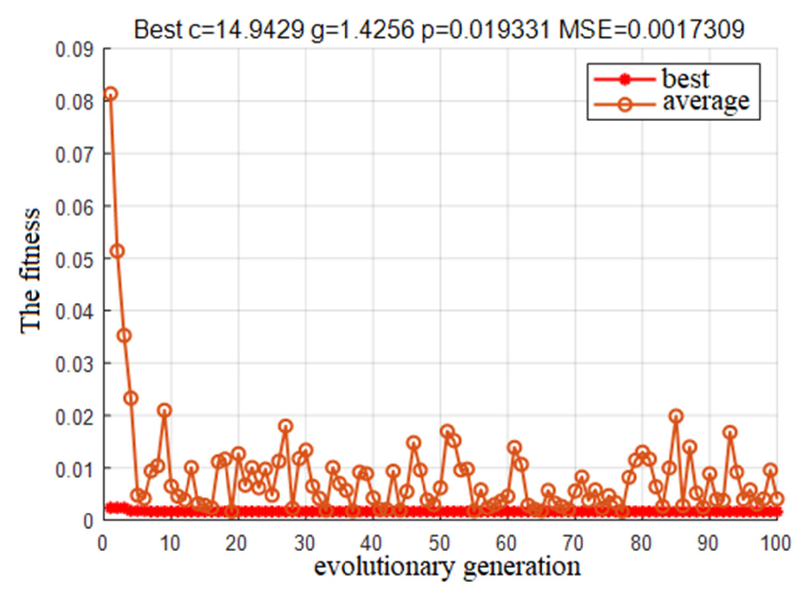
Figure 14. GA-cgp parameter optimization fitness curve.